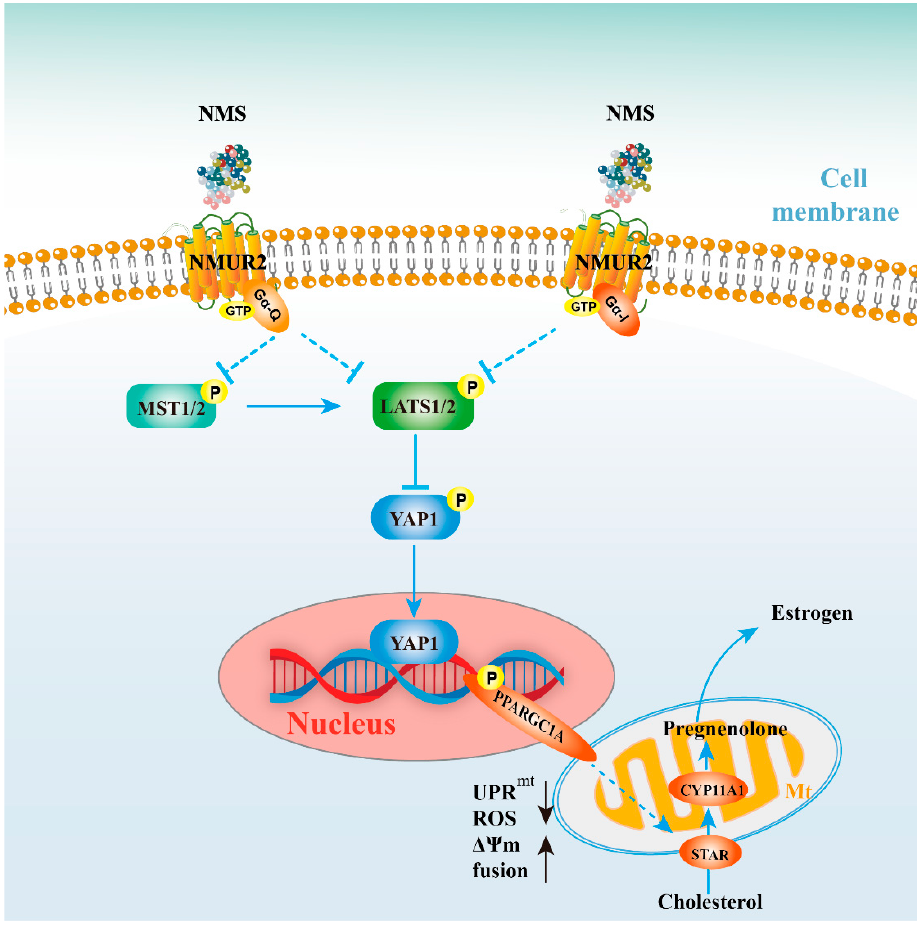
Figure 8. Schematic diagram for NMS regulates steroidogenesis, possibly via the NMUR2/YAP1/PPARGC1A pathway, in ovarian granulosa cells. NMS in GCs regulates steroidogenesis by affecting mitochondrial morphology, mitochondrial unfolded protein response, mitochondrial membrane potential, the activities of mitochondrial respiratory chain complexes, adenosine triphosphate level, and cellular reactive oxygen species production, which is possibly mediated through the NMUR2/YAP1/PPARGC1A pathway.